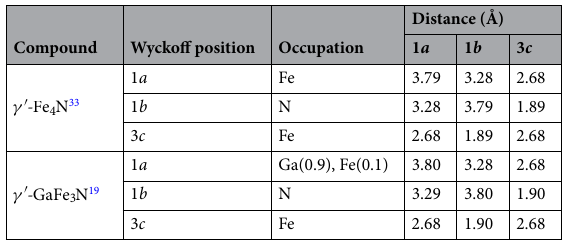
Table 3. Literature values of the occupation sites and coordination distances in the Pm ¯ 3 m fcc crystal structure of γ ′ - Ga y Fe 4 − y N